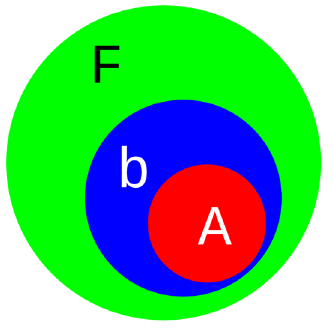
Figure 2. Definition of a system with active, buffer and frozen regions in frozen domain EFMO.